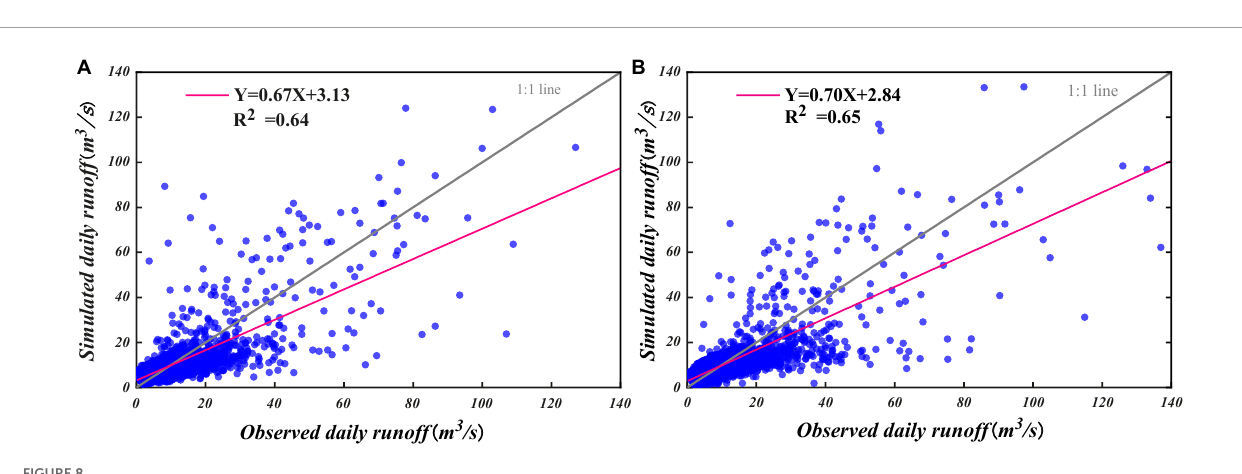
FIGURE8 Scatter graphs of the observed and simulated data at (A) calibration and (B) validation.